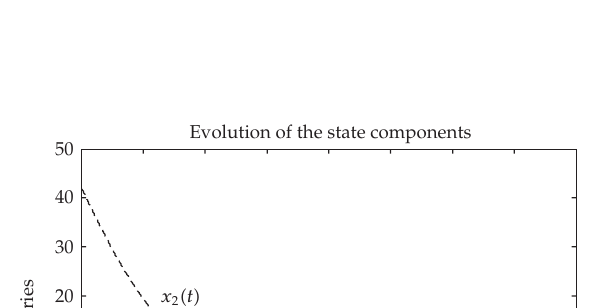
Figure 2: Type of state-feedback control law.